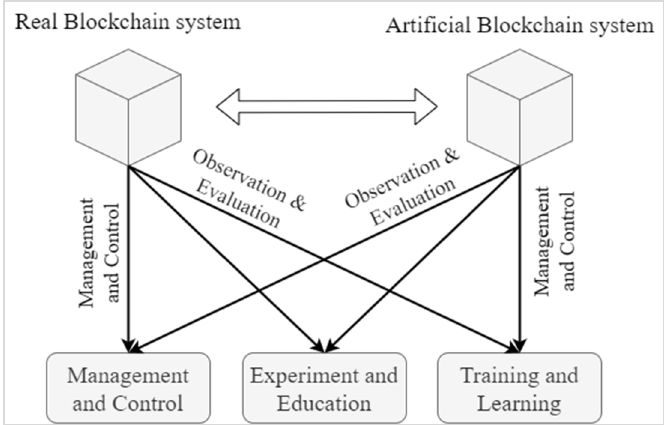
Figure 4. A framework of parallel security on the